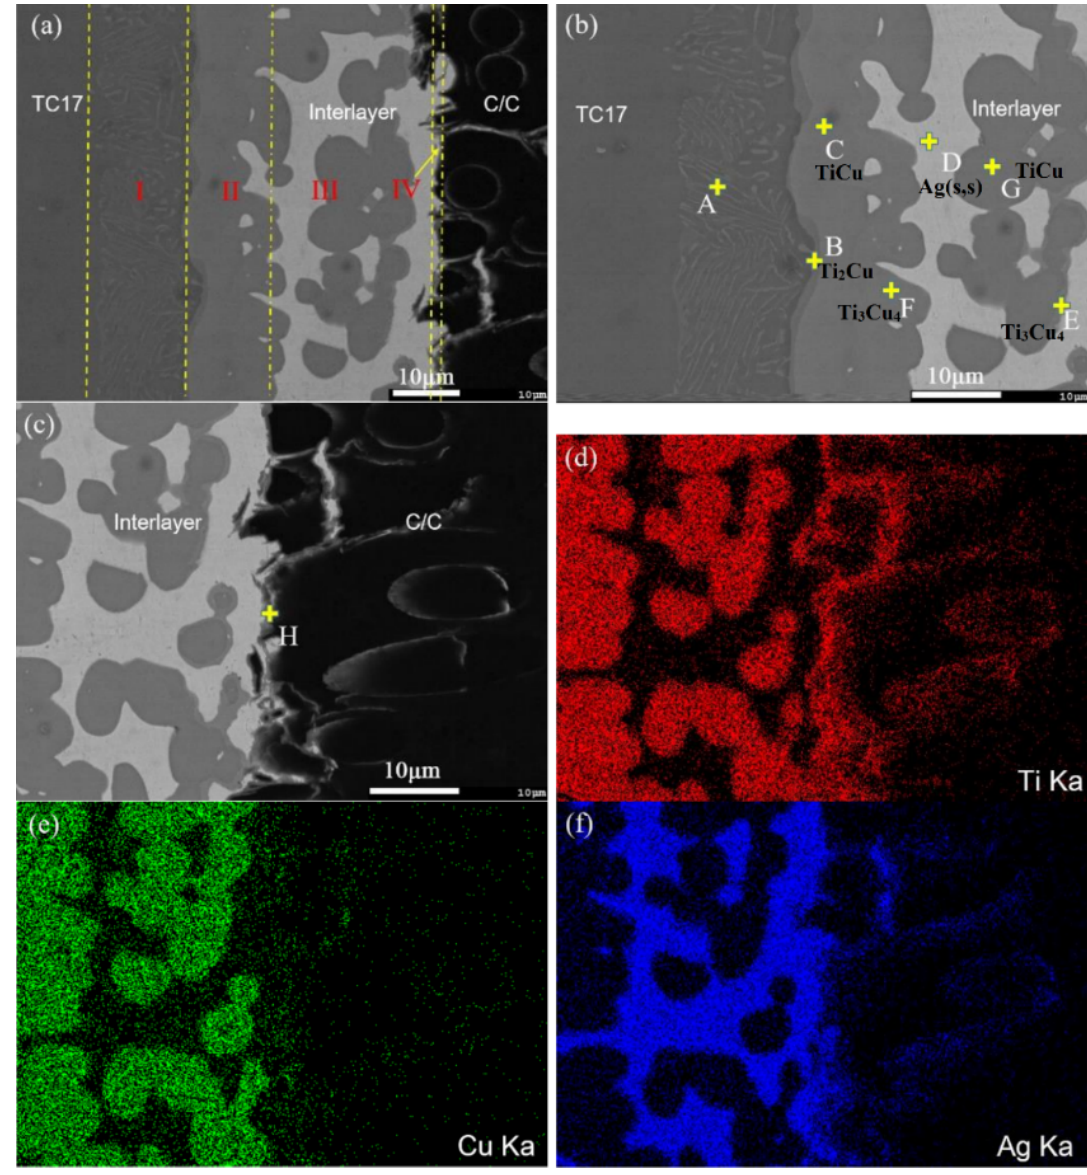
Figure 1: Back-scattered electron image of C/C composite/ AgCuTi/ TC17 joint.